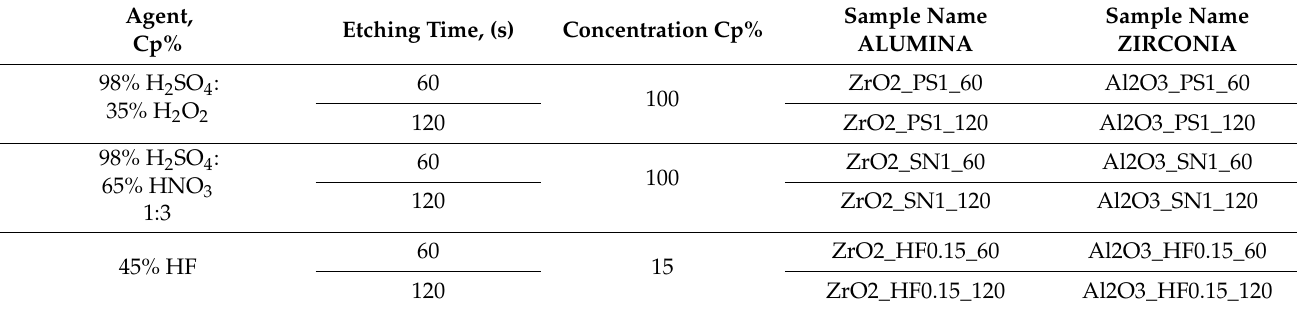
Table 1. All sample’s experimental conditions and description for both ceramic